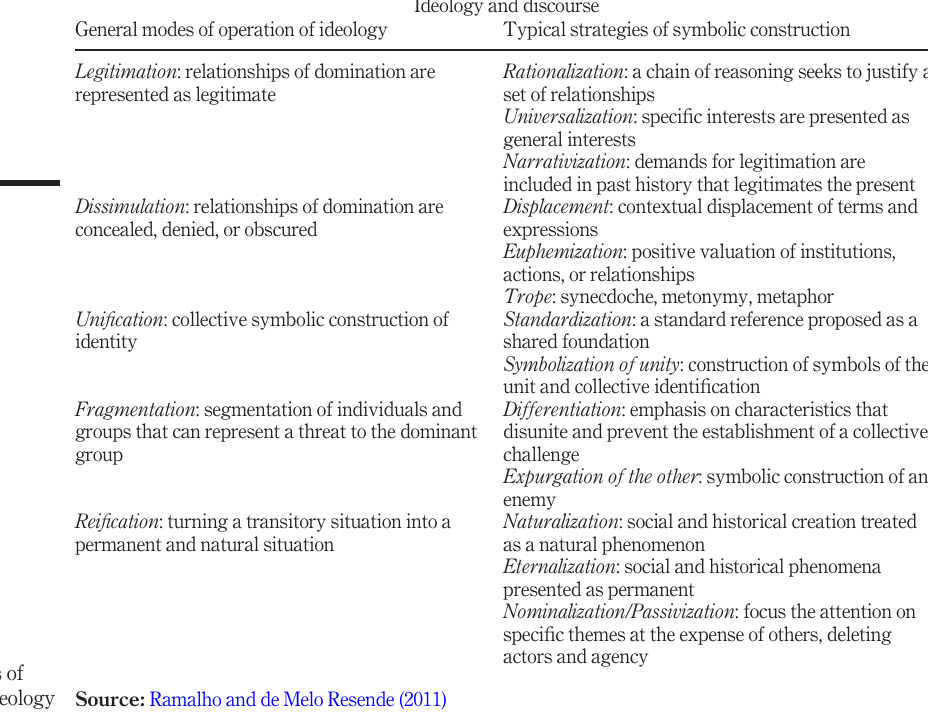
Table III. General modes of operation of